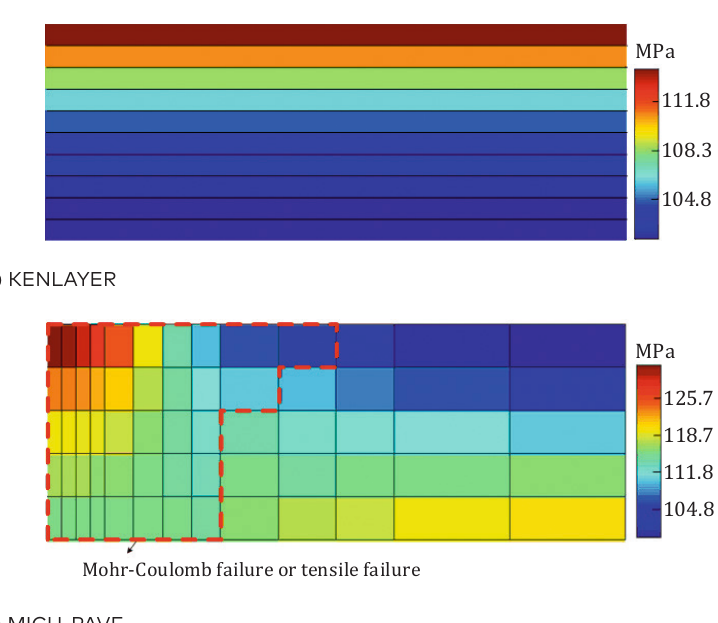
Figure 10. The distribution of the resilient modulus in the granular base layer at the end of the